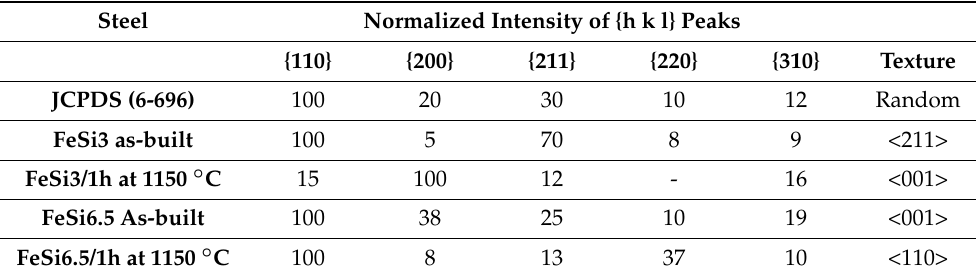
Table 7. Intensity of the XRD peaks of FeSi3 and FeSi6.5 steels samples, in as-built condition and after heat treatment at 1150 °C for one hour. Peak intensities are normalized to the most intense one of each XRD pattern (I = 100). The intensities of a Fe sample with randomly oriented grains (JCPDS-X-ray database-File 6-696) are reported for estimating the texture of the examined materials.